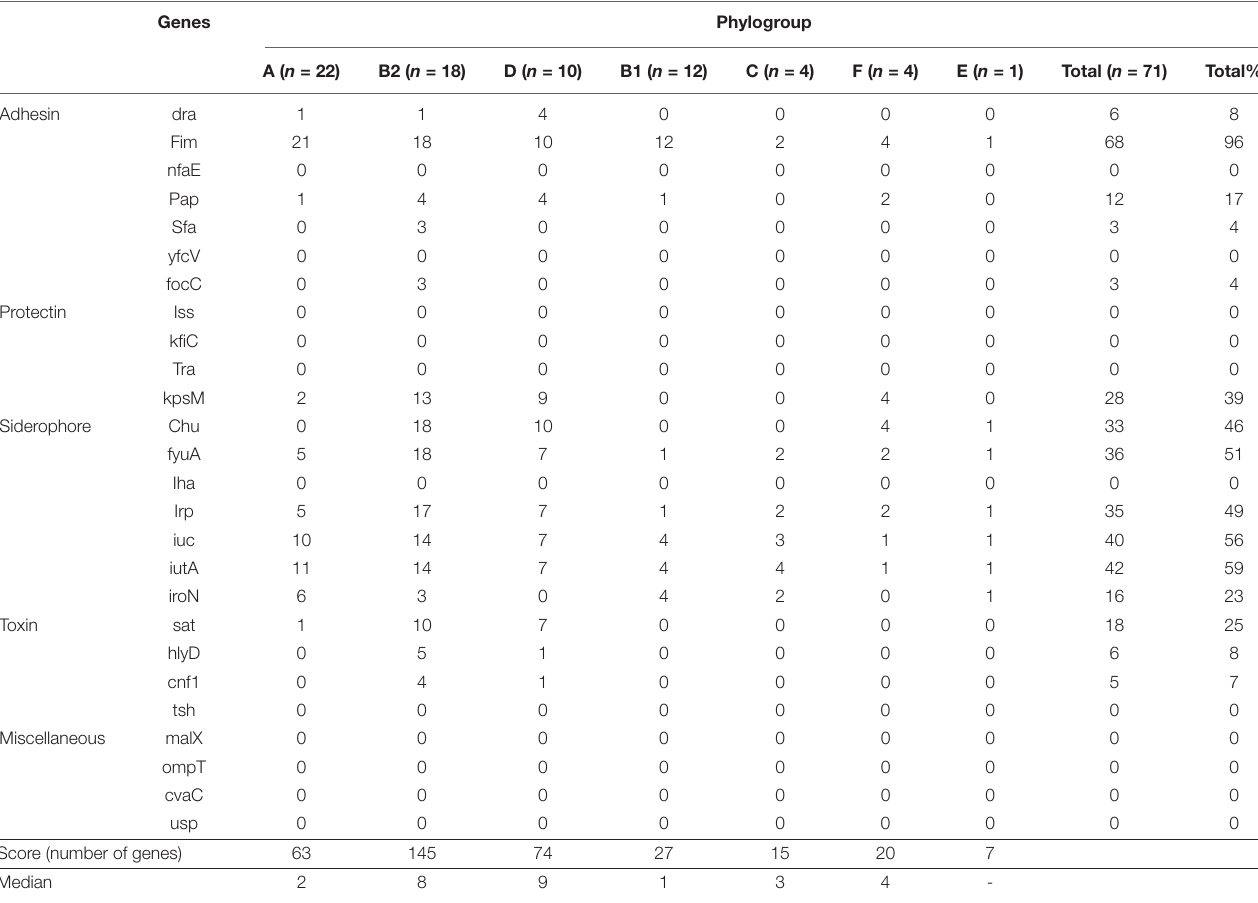
TABLE 2 | Virulence gene content per phylogroup, median, and total scores.